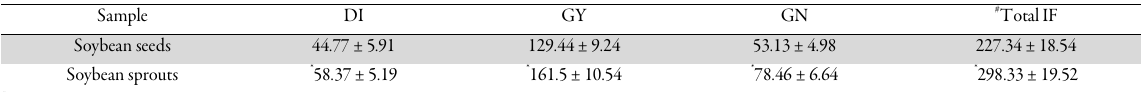
Table 3. Detection and quantification of total and individual aglycone IF contents from soybean mature seed- and sprout-flours